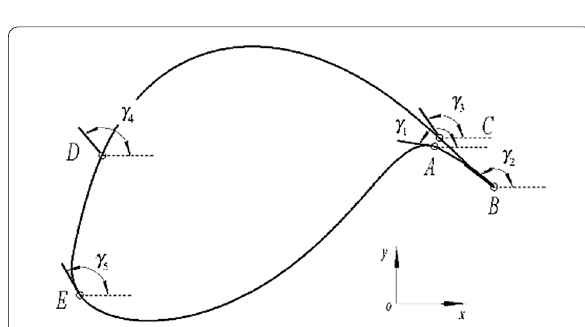
Figure 2 Trajectory and key points for obtaining the required position and orientation